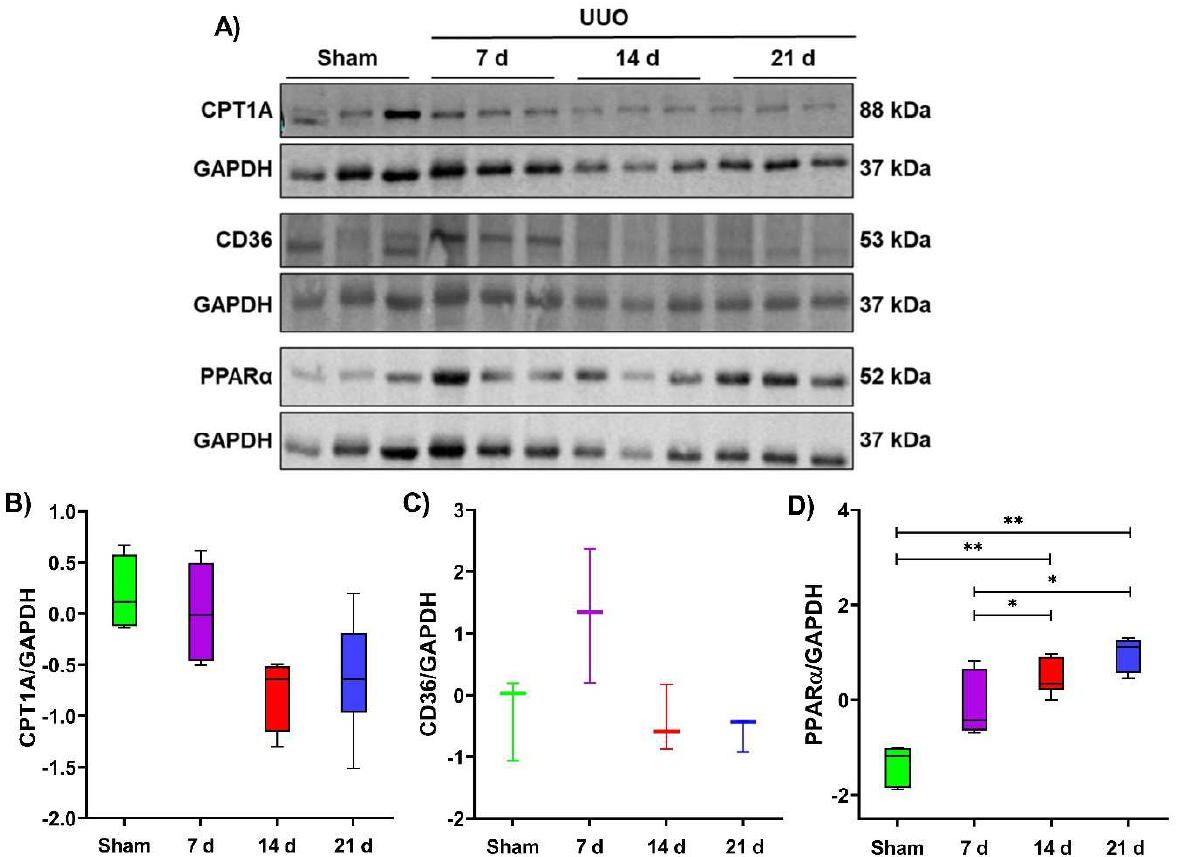
Figure 5. Fatty acid (FA) β –oxidation markers in the temporal model of the unilateral ureteral obstruction (UUO). ( A ) Representative blots of carnitine palmitoyltransferase 1 (CPT1A), CD36, peroxisome proliferator–activated receptor alpha (PPAR α ) as markers of fatty acid (FA) β –oxidation during 7, 14, and 21 days after the UUO, and glyceraldehyde 3–phosphate dehydrogenase (GAPDH) used as a loading control. ( B – D ) Expression of markers fatty acid (FA) β–oxidation. GAPDH was used as the loading control. All Western blot measurements were performed in whole tissue lysate. Data are represented as mean ± SD of one or two technical replicates from three rats per group; each technical replicate was standardized Z( µ = 0, σ ). * p < 0.05, ** p <